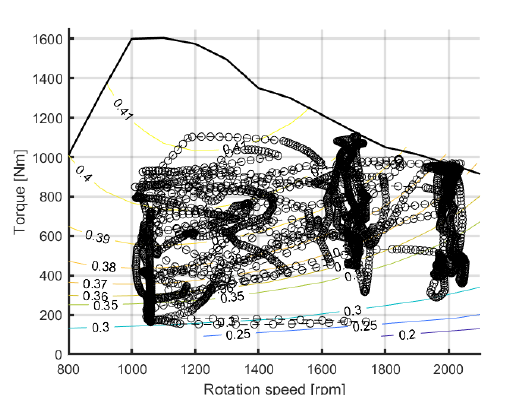
Figure 14: Working points of parallel hybrid with 202 kW engine